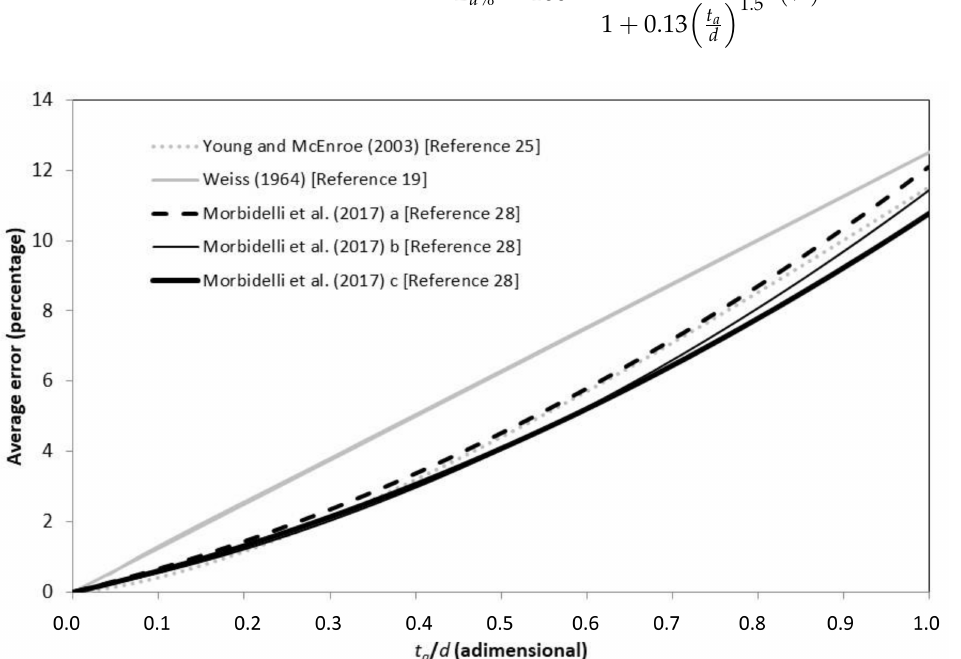
Figure 8. Average underestimation error of the annual maximum rainfall depth for different values of the ratio between time resolution, t a , and duration, d , obtained by Equation (7) [19], Equation (8) [25], and Equations (9)–(11) [28]. In this last case, symbols “a”, “b”, and “c” stand for d ≤ 30 min, d in the interval between 30 and 180 min, and d ≥ 180 min,